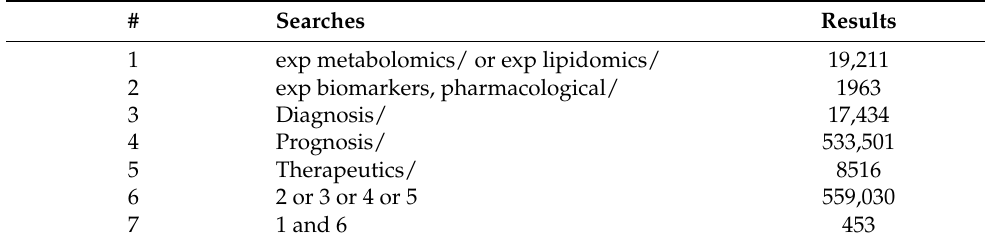
Table 3. Summary of the MeSH search terms conducted for the retrieval of recent studies in